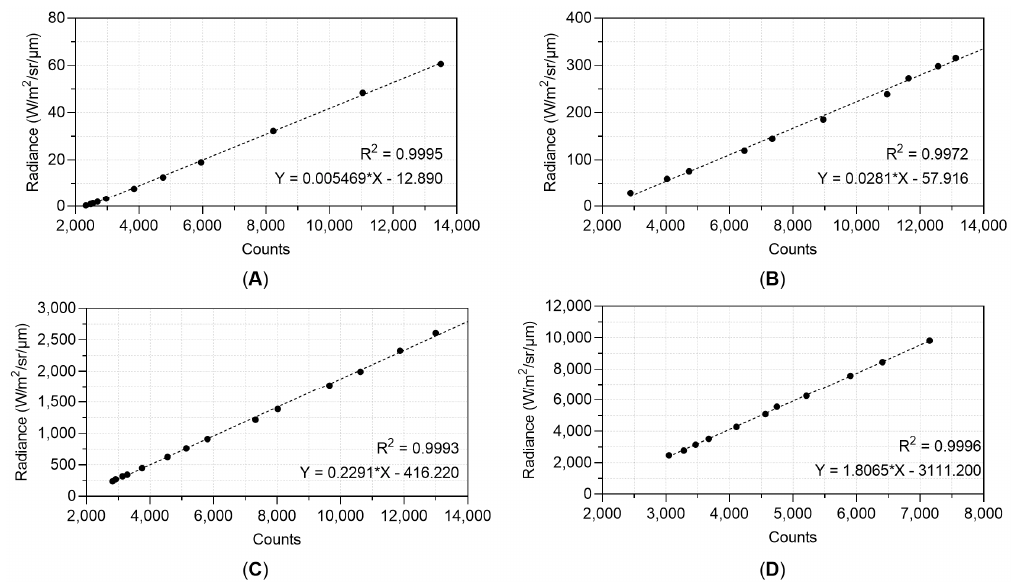
Figure 8. Relationship between counts recorded by the FLIR sensor and calculated radiance using the Planck function and a wavelength of 3.74 µm at integration times of ( A ) 1.4 ms, ( B ) 0.3 ms, ( C ) 0.04 ms, and ( D ) 0.0021 ms modified from [36]. The equations yielded by the trend line at each integration time were used to calculate radiance across each frame recorded by the sensor.